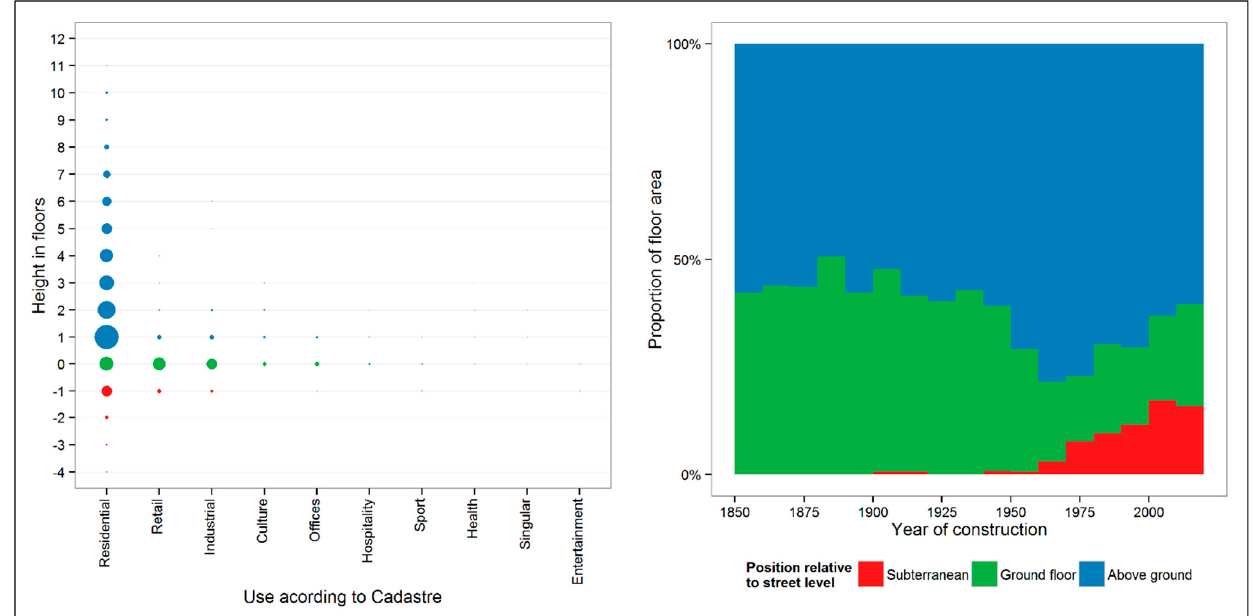
Figure 19. Built area per floor and use ( left ) and temporal evolution relative to street level ( right